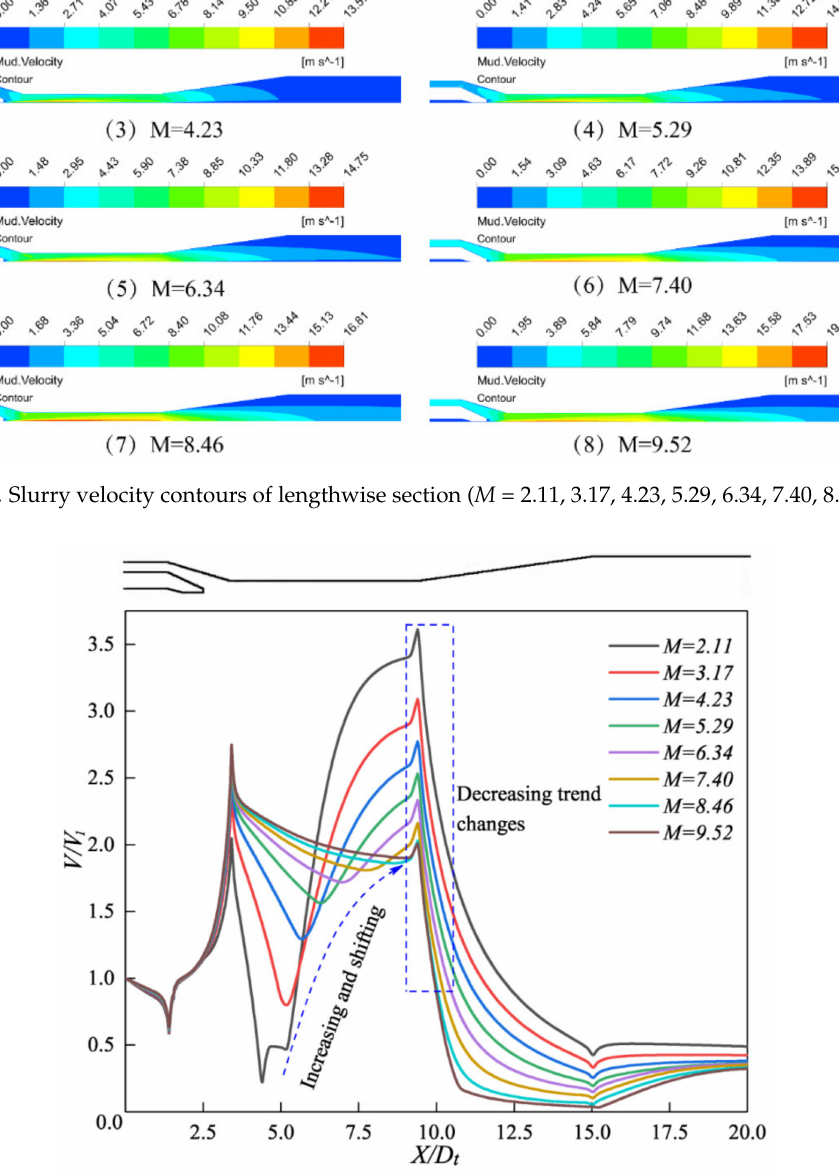
Figure 11. Wall velocity distribution of slurry from nozzle inlet to exit ( M = 2.11, 3.17, 4.23, 5.29, 6.34, 7.40, 8.46, 9.52).